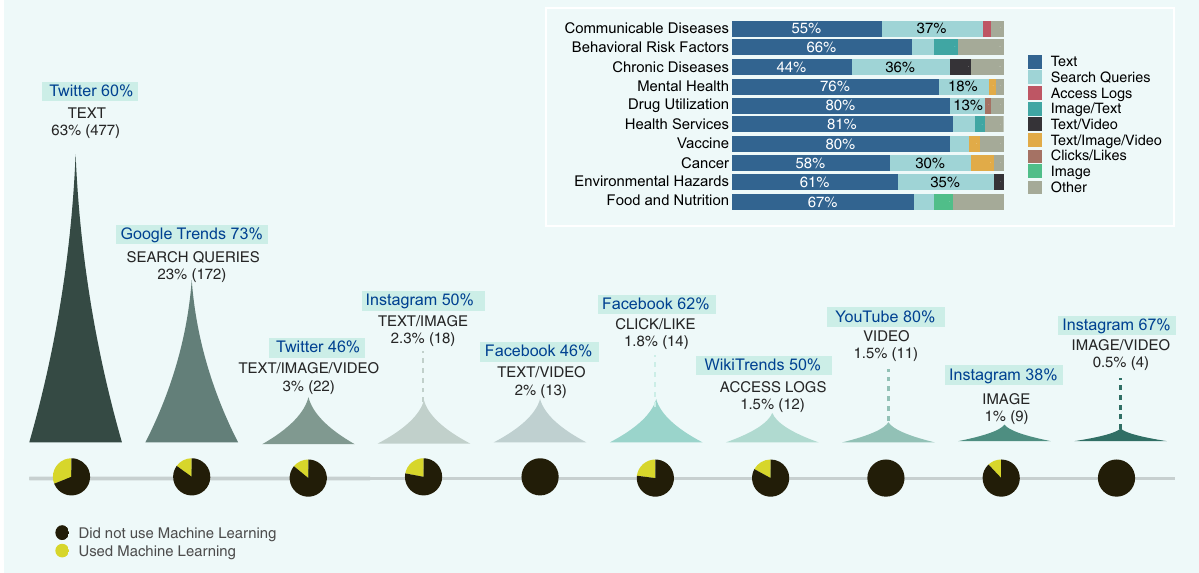
Fig. 7 Data types and analysis methods. The mapping between data types used by the included studies and the PHS systems, platforms, and the use of machine